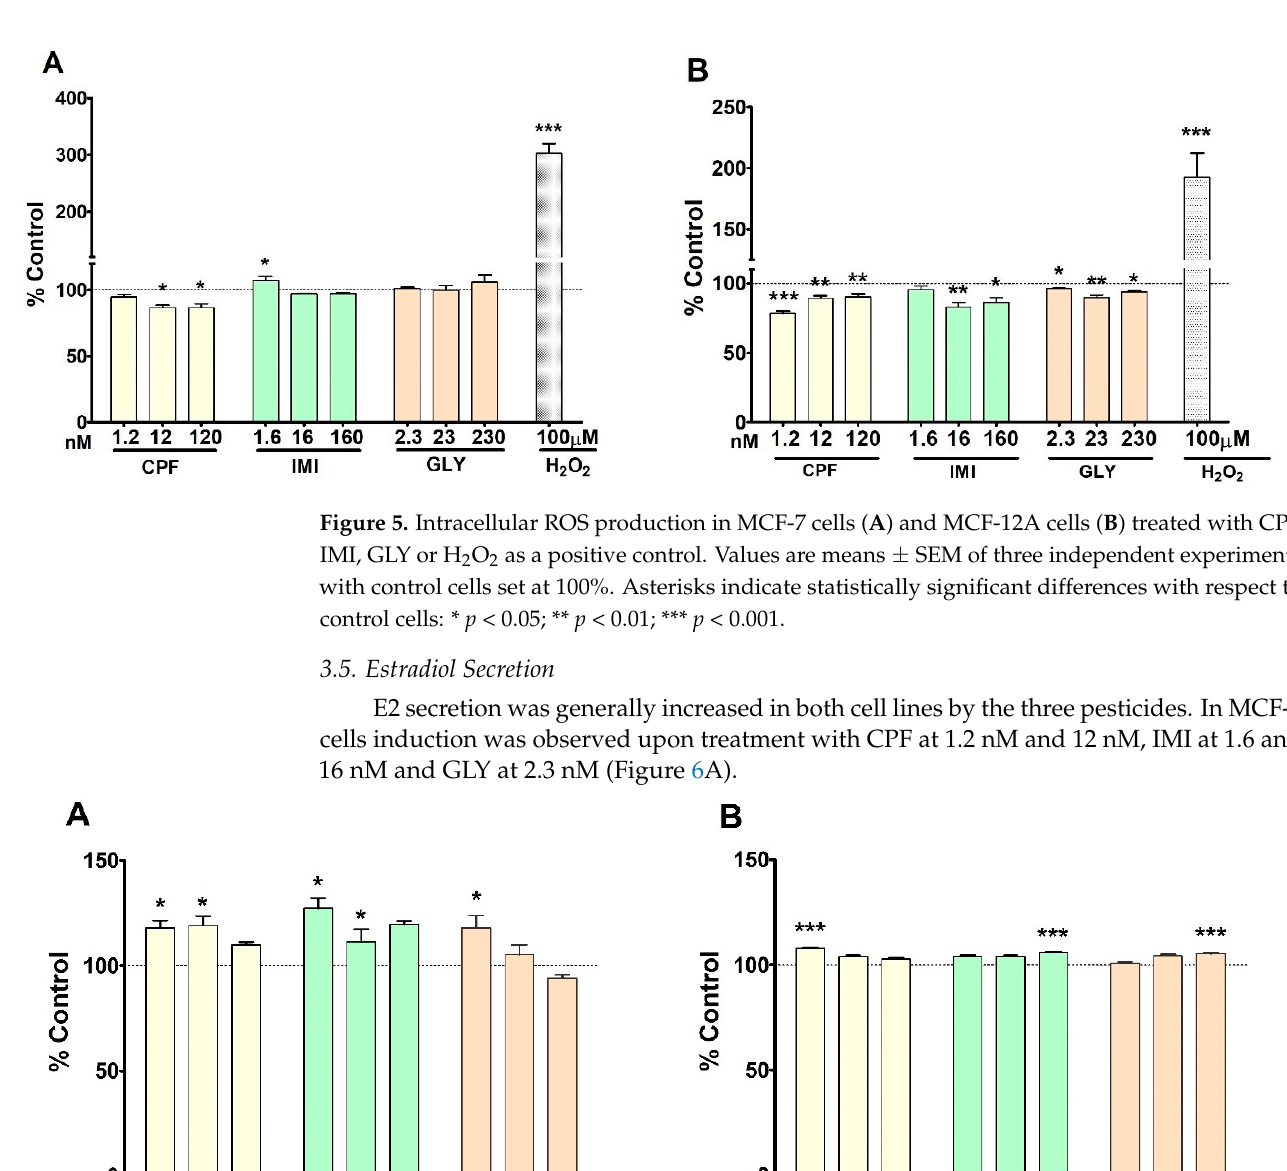
Figure 6 . E2 secretion in MCF-7 cells ( A ) and MCF-12A cells ( B ) following treatment with CPF, IMI and GLY or medium alone as a control, for 72 h. Values are means ± SEM of three independent experiments with control cells set at 100%. Asterisks indicate statistically significant differences with respect to control cells: * p < 0.05; *** p < 0.001.